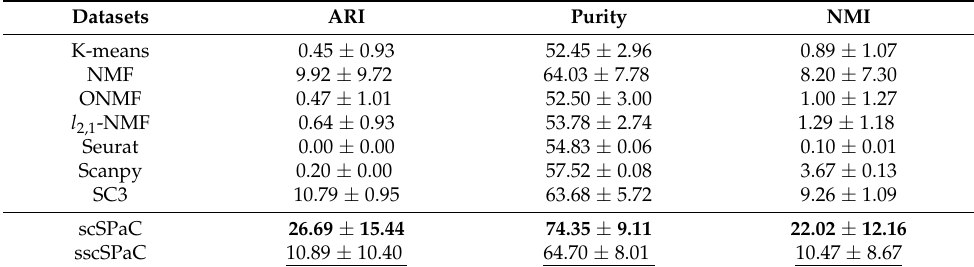
Table 2. Evaluation of clustering performance on simulated data. The highest score for each dataset is shown in bold and the second best score is underlined. The values in the table represent the (mean ± std). Datasets